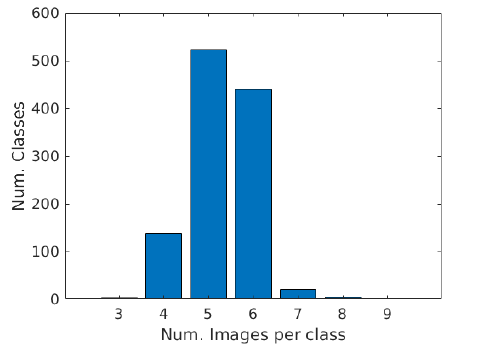
Figure 1. Distribution of the classes within the T1K+